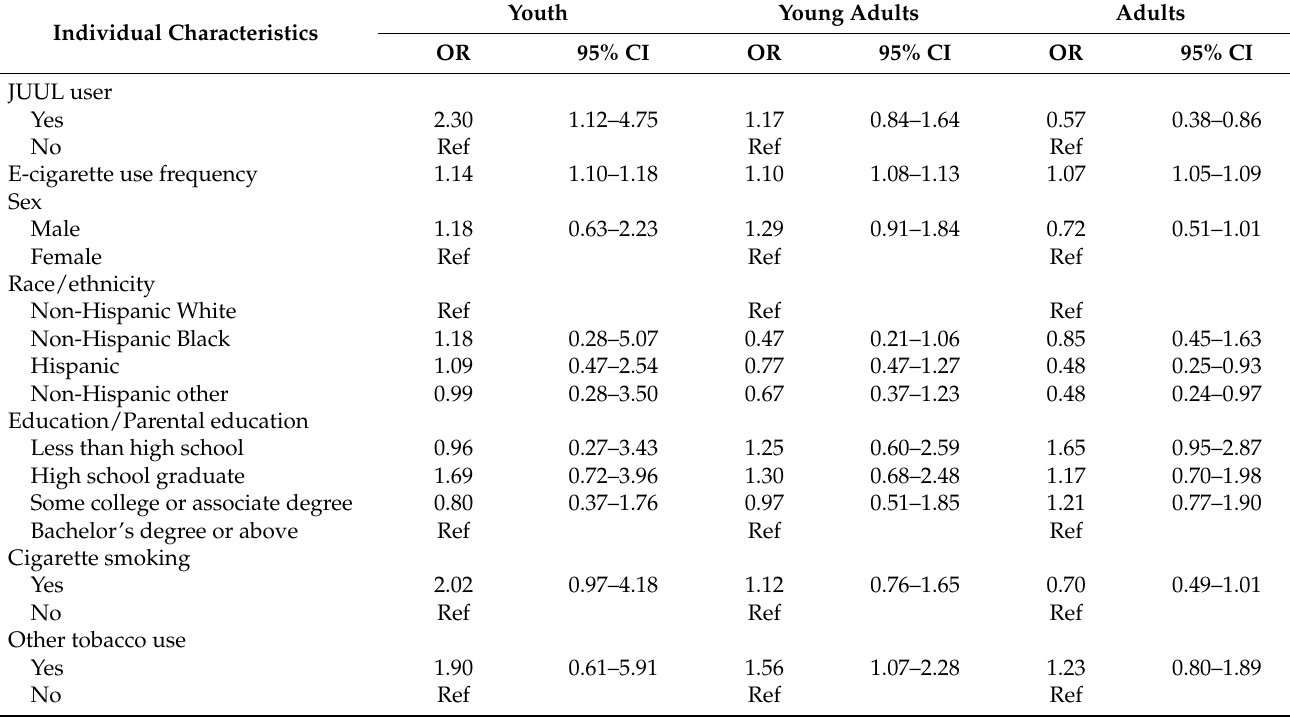
Table 2. Association between e-cigarette dependency (measured as using e-cigarette within 30 min after waking) and JUUL use among U.S. youth, young adults, and